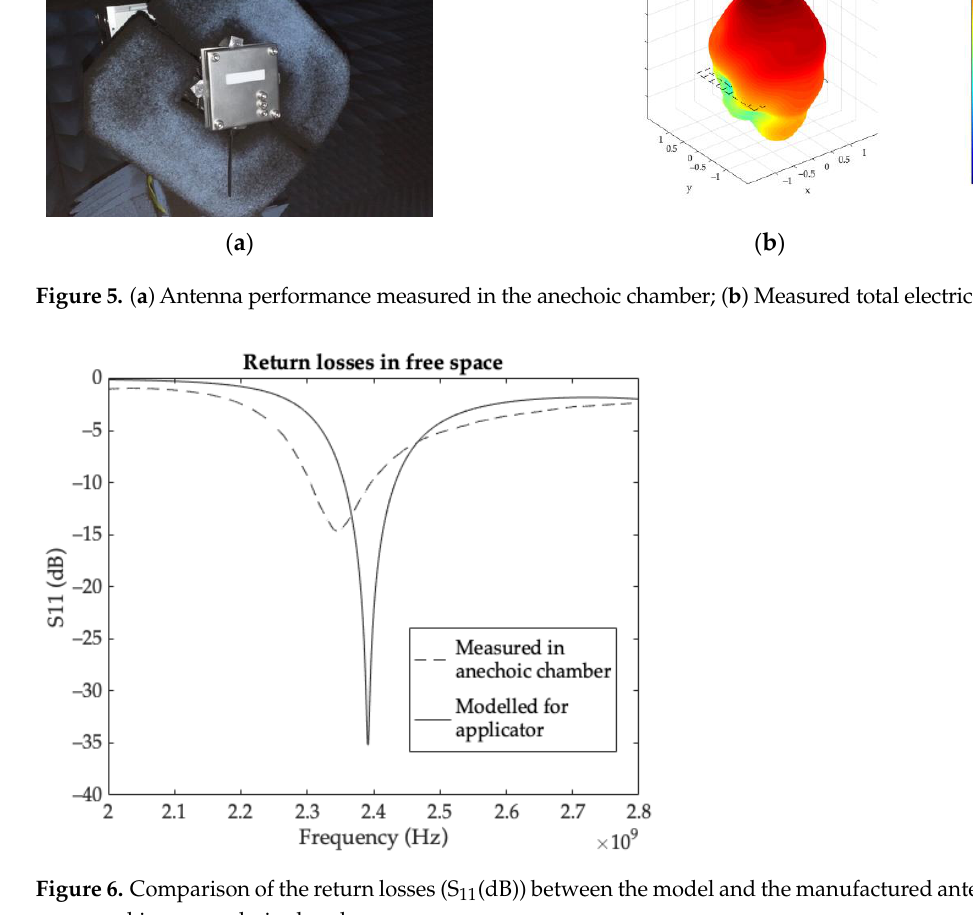
Figure 8. Comparison between the S11 parameters of the measurement with the antenna feeding a commercial microwave oven and the model. Table 2. Power measurements of the 2-liter test. Parameter